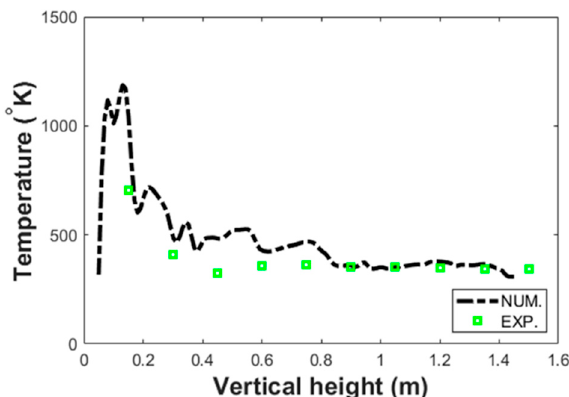
Figure 2. Numerical prediction of temperature at domain centreline, compared with experimental measurements.